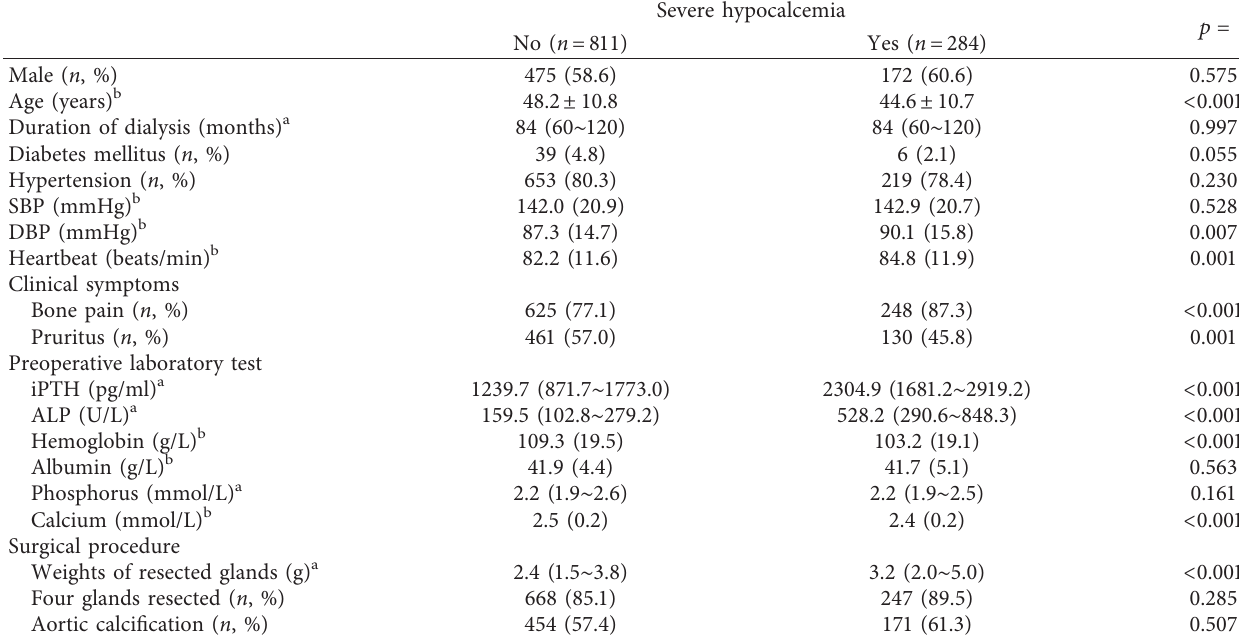
Table 2: Preoperative indicators of patients in the SH and non-SH